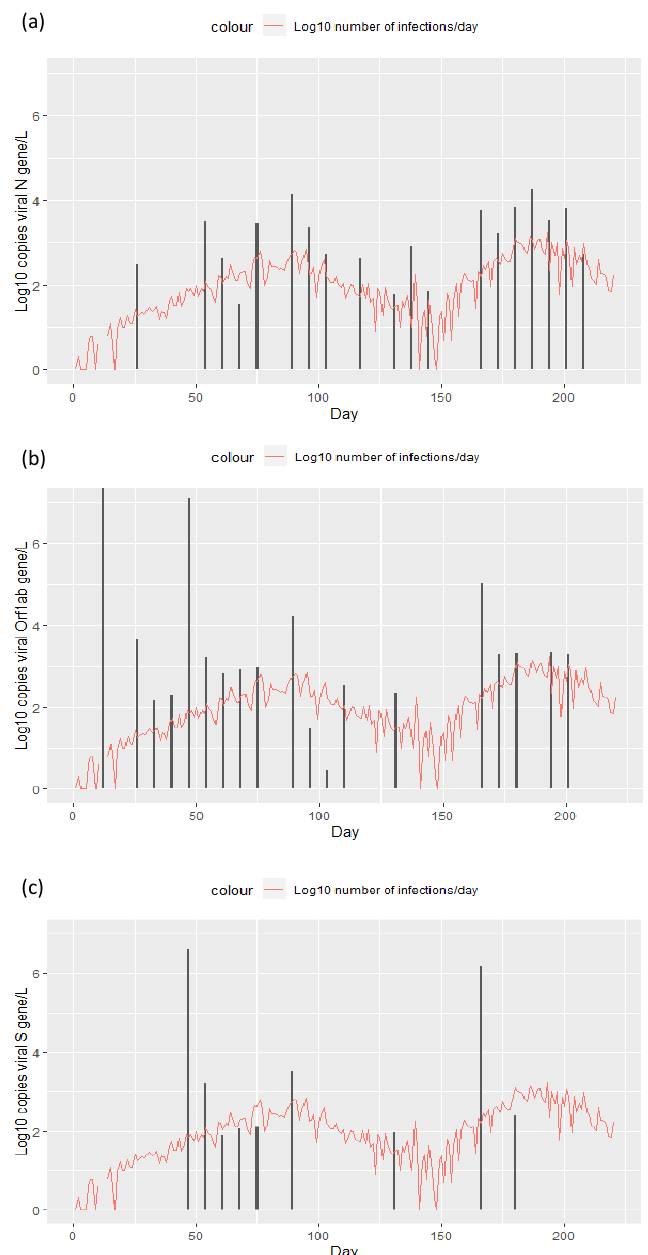
Figure 1. Log10 transformed number of daily reported SARS-CoV-2 infections in the Sibiu municipal- ity between August 2021 and March 2022 (red line), and the log10 tranformed amount of viral RNA found in wastewater sampled once a week and quantified based on the presence of the viral genes ( a ) N gene, ( b ) Orf1 ab gene and ( c ) S gene (black